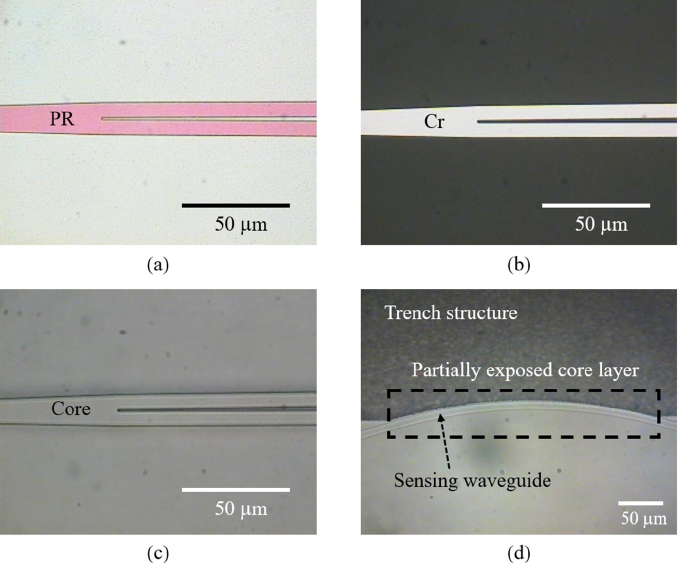
Figure 4. Optical images of the integrated PLC sensor probe device following the fabrication proce- dure: ( a ) photoresist pattern; ( b ) Cr mask pattern; ( c ) core pattern; ( d ) conformal aligned trench structure.